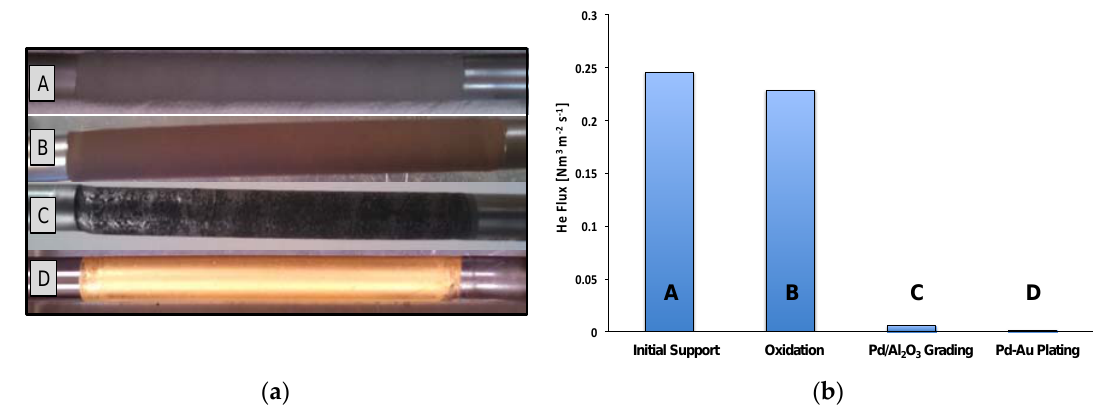
Figure 8. ( a ) fabrication Steps: [A] Initial support [B] Oxidation at 500 °C [C] Grading [D] Final Pd ‐ Au metallic layer; ( b ) He permeating flux during membrane progress ( Δ p = 1 bar, T = 25 °C).